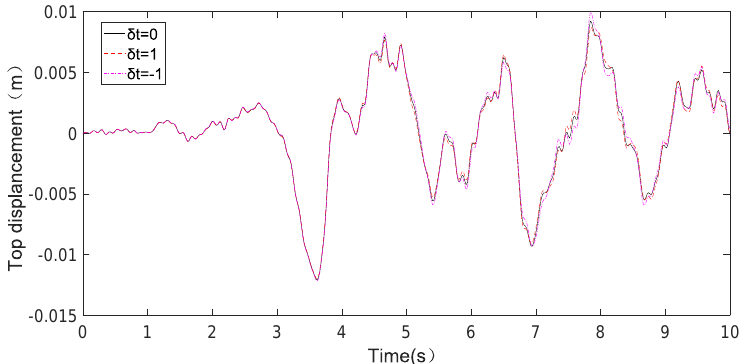
Figure 20. Top floor displacement curve of the uncertain structure under the Taft wave.